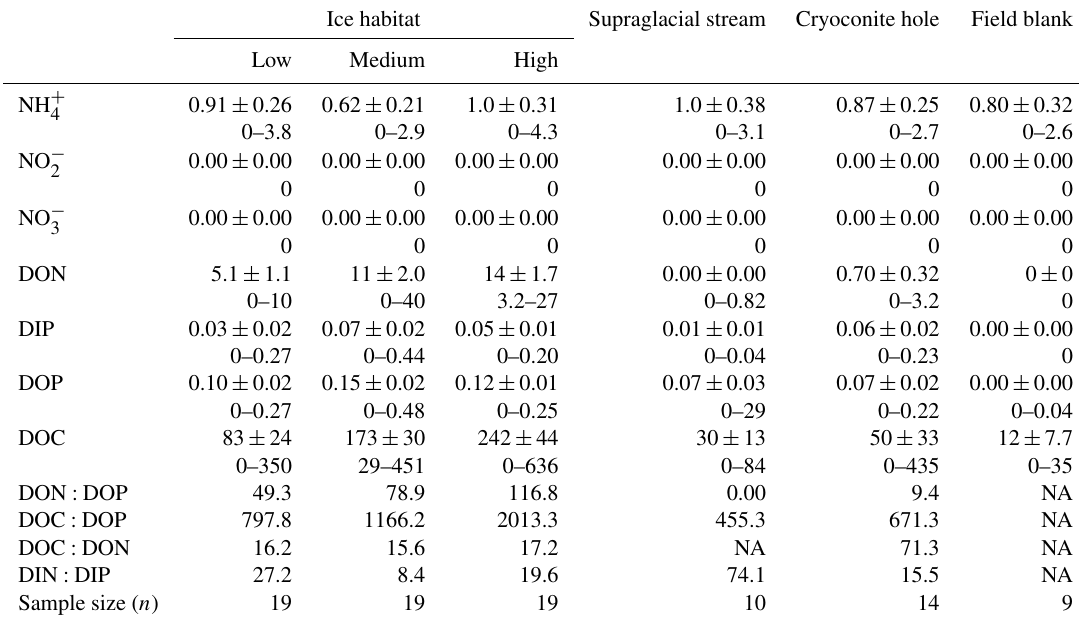
Table 1. Summary statistics for dissolved macronutrient (N and P) and DOC concentrations in the five supraglacial habitats. DON, DIP, DOP and DOC denote dissolved organic nitrogen, dissolved inorganic phosphorus, dissolved organic phosphorus and dissolved organic carbon, respectively. For each nutrient, the mean ± SD is provided, followed by the range of values. Concentrations are expressed in µM; nutrient ratios are in µMµM − 1 .